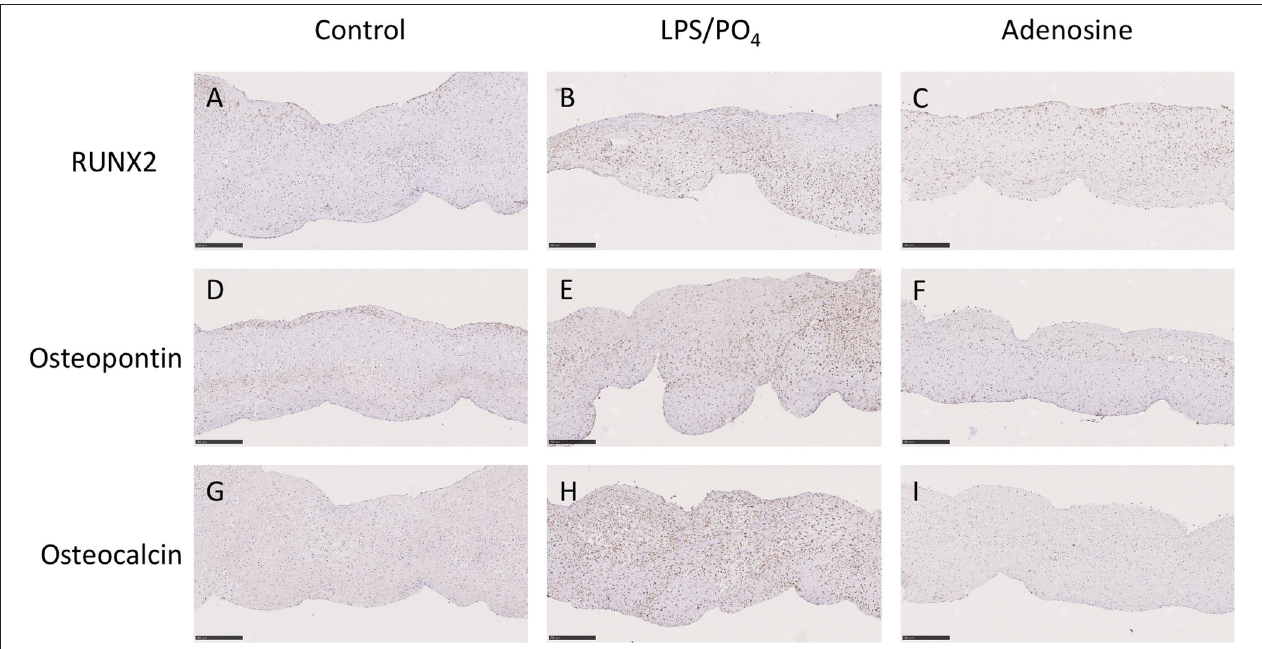
FIGURE 9 | Effect of adenosine on the expression of osteogenic markers. Immunohistochemical staining in media alone (left column), 100ng/mL LPS 3 µ M phosphate treated (center column) and 100ng/mL LPS 3mM phosphate and 10 − 5 M adenosine treated (right column) valve leaflets. Section were stained with RUNX2 (A–C) , osteopontin (D–F) and osteocalcin (G–I) . Scale bar, 100 µ